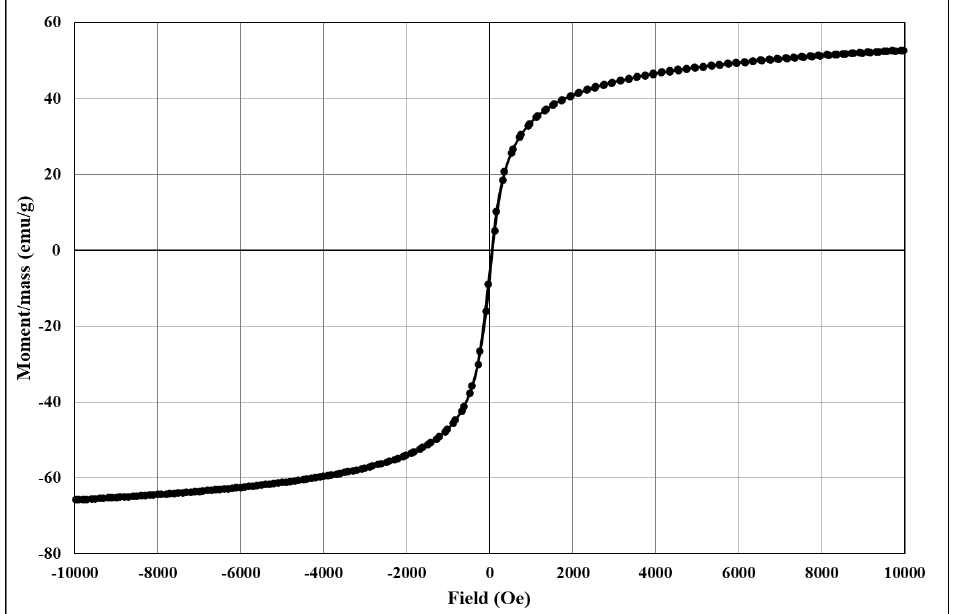
Figure 7. The magnetization/mass ratio for Fe 3 O 4 @citrate@1c.